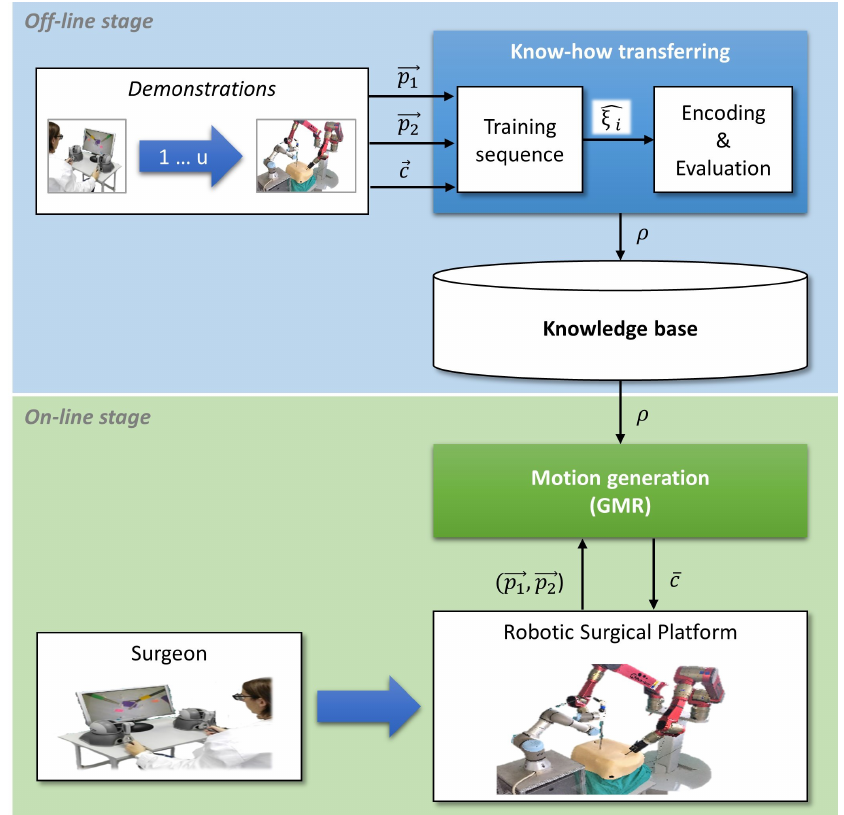
Figure 2. Learning for demonstration approach for autonomous camera